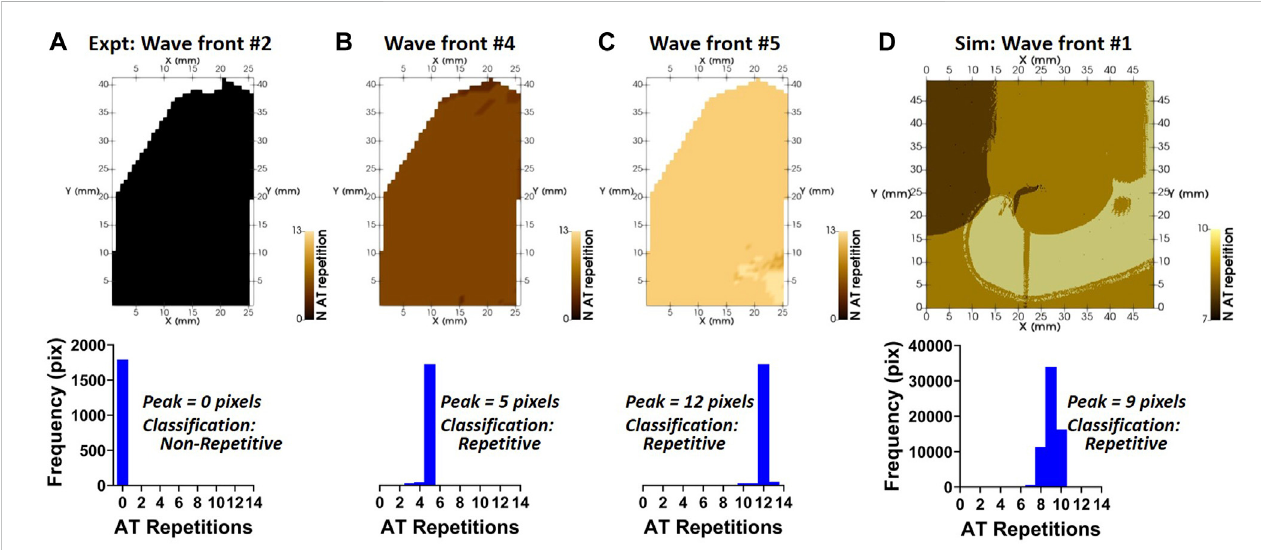
FIGURE 7 Repetitive/non-repetitive classi fi cation of wave fronts. (A — D) Wave fronts shown in Figure 5 were classi fi ed as repetitive or non-repetitive. The spatial distributionofthenumber ofrepetitionsofactivationfor each wave front(upperpanels)and their histograms(lower panels) areshown. Labels wereclassi fi ed as repetitive if the histogram peak of activation repetitions was ≥